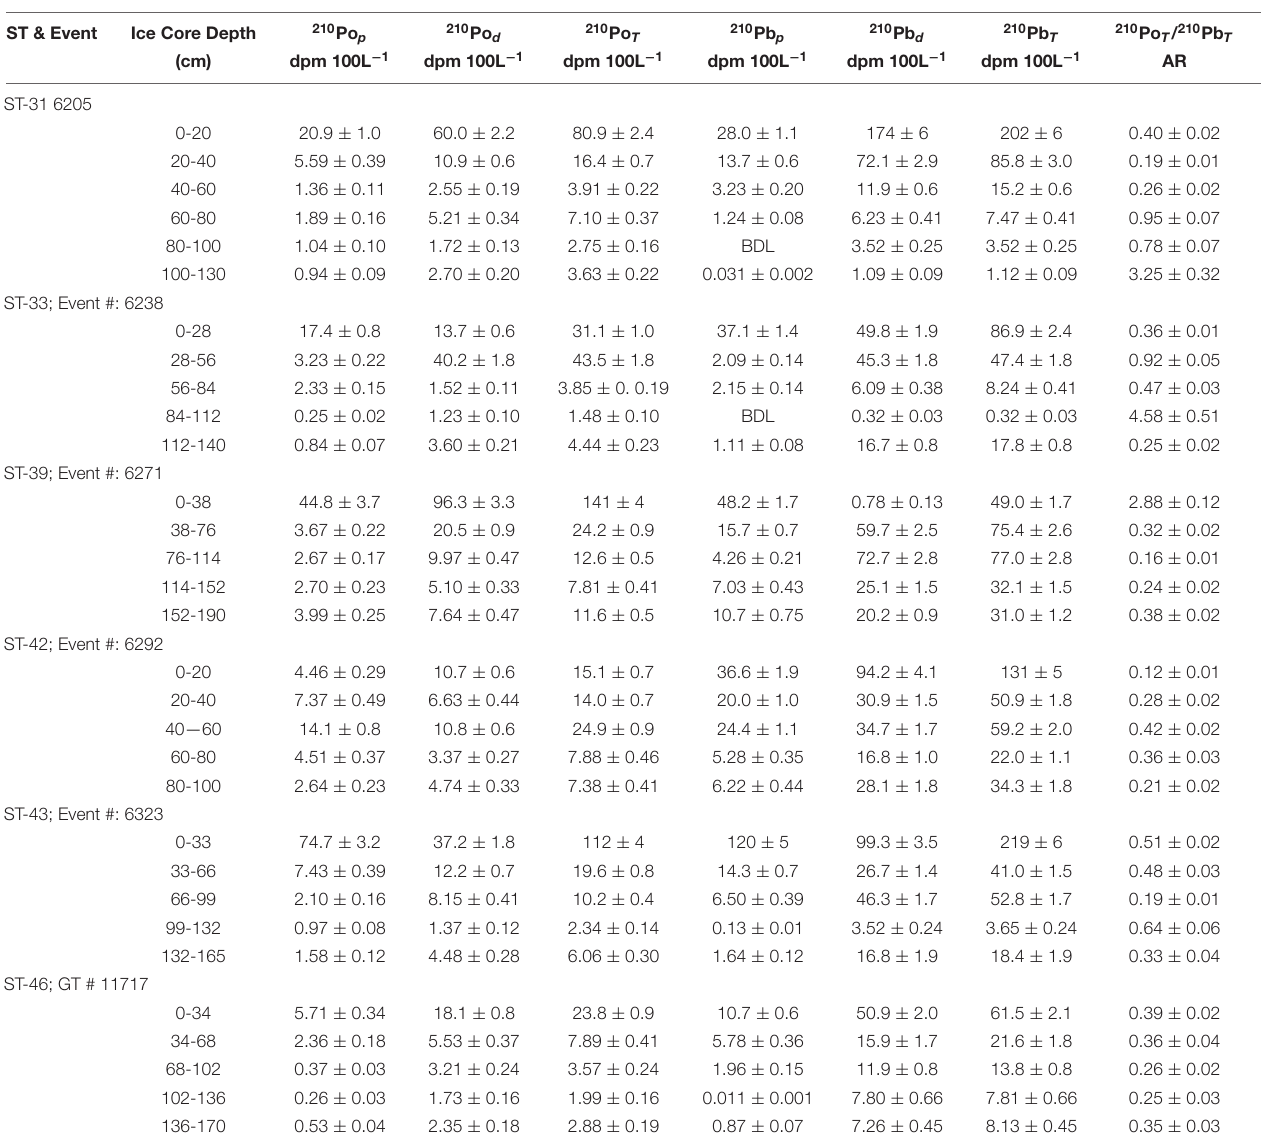
TABLE 6 | Dissolved, particulate, total activities and activity ratios for ice station